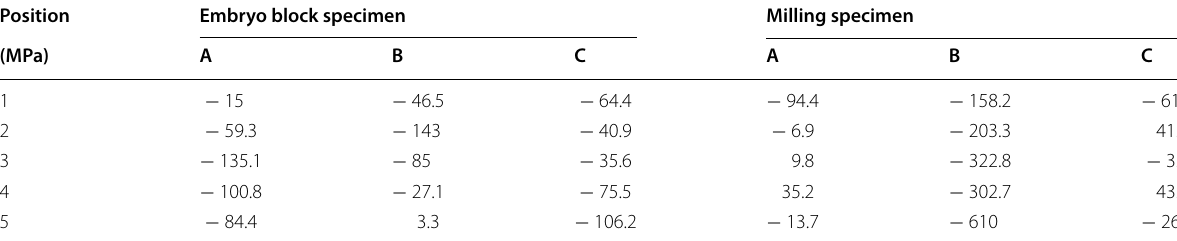
Table 4 X-ray results of residual stress distribution in specimens Position Embryo block specimen Milling